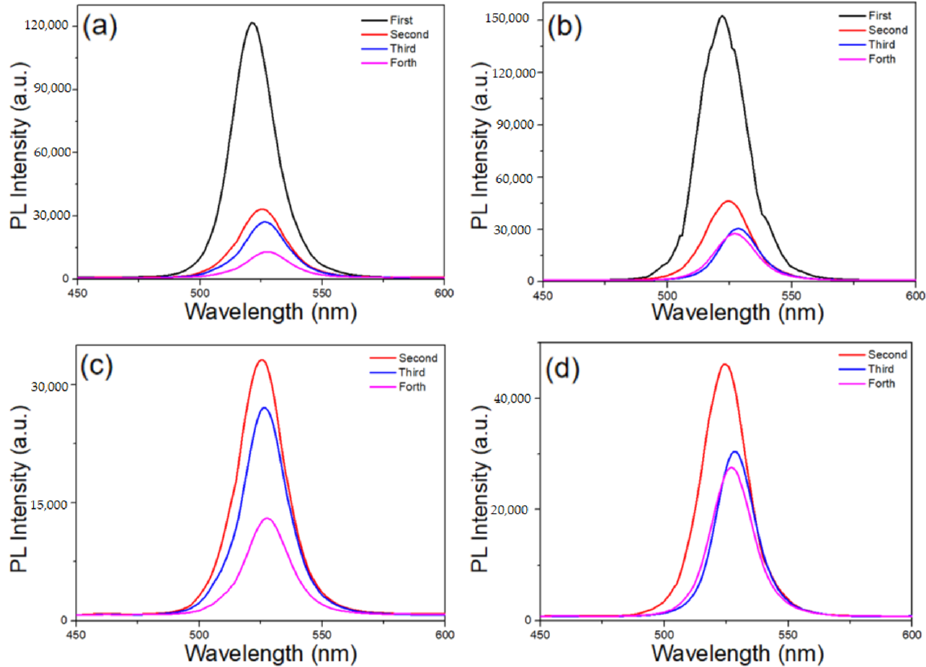
Figure 7. The PL spectra of ( a ) pure CsPbBr 3 QDs and ( b ) SBA-15 CsPbBr 3 QDs after heating and cooling cycle. The PL spectra of ( c ) pure CsPbBr 3 QDs and ( d ) SBA-15@CsPbBr 3 QDs’ heating and cooling cycle for the last three times.